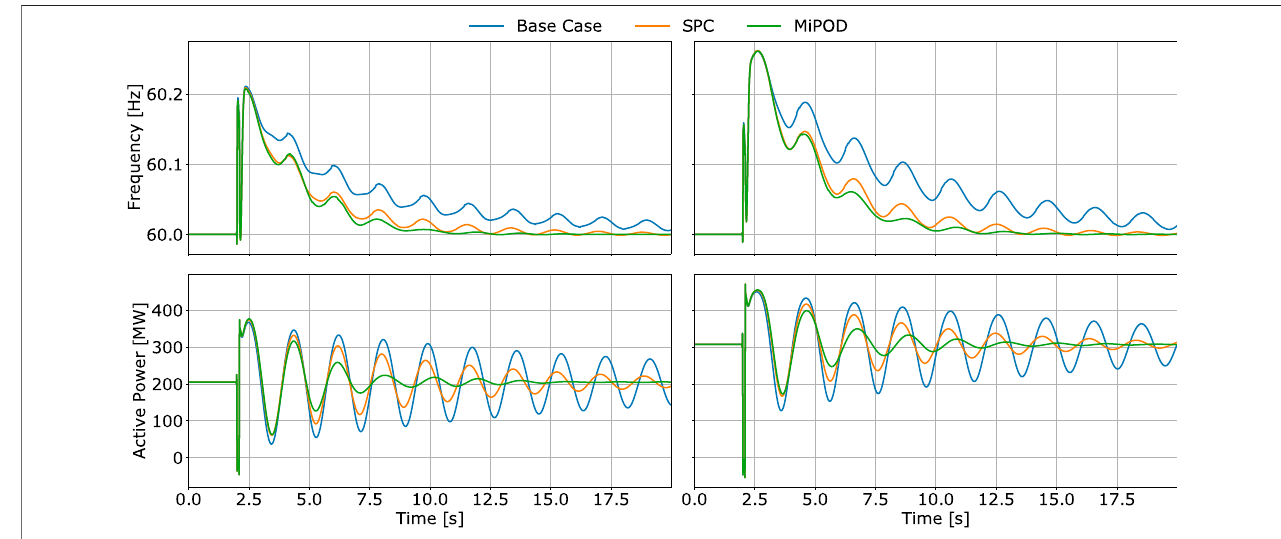
FIGURE19| Systemfrequencyandactivepower fl owatB08afterasymmetricalfaultatB07for2randomoperatingpointswhilethelowerlineconnectingB08and B09 is out of service.